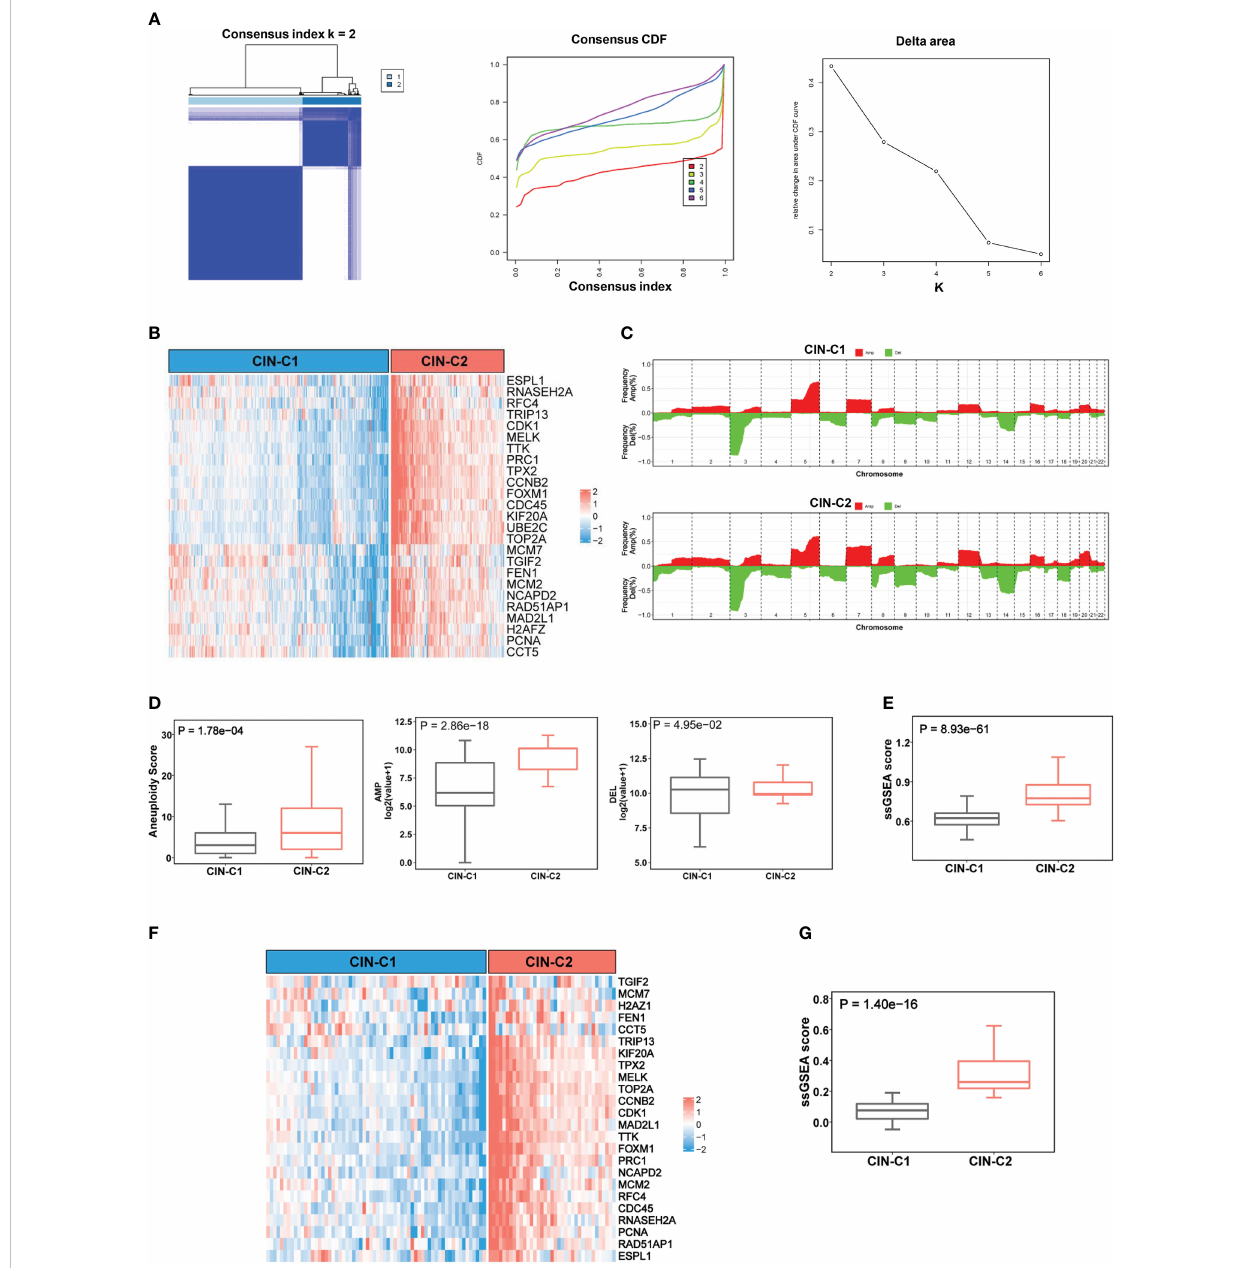
FIGURE 2 CIN25 signature-based classi fi cation of ccRCCs. (A) Consensus clustering of ccRCC tumors according to expression of CIN25 genes. A two-cluster classi fi cation of ccRCC tumors was optimal CIN25 signature-based clustering based on the K value from nonnegative matrix factorization. CDF: Cumulative distribution function. (B) TCGA ccRCC tumor clustering. Tumors were categorized into two clusters: CIN25-C1 (low) and CIN25-C2 (high). (C) Global copy number alterations (CNAs) in CIN25-C1 and CIN25-C2 tumors. The plots show frequencies of gain/ampli fi cation (Red) and deletion (Green) in 22 chromosomes. Top and bottom: CIN25-C1 and CIN25-C2, respectively. (D) Differences in the total aneuploidy score, and ampli fi ed and deleted scores between CIN25-C1 and CIN25-C2 tumors. (E) Differences in CIN25 ssGSEA score between CIN25-C1 and CIN25-C2 tumors. (F) CIN25 signature-based clustering of ccRCC tumors in the E-MTAB1980 cohort. (G) Differences in CIN25 ssGSEA score between CIN25- C1 and CIN25-C2 tumors in the E-MTAB1980